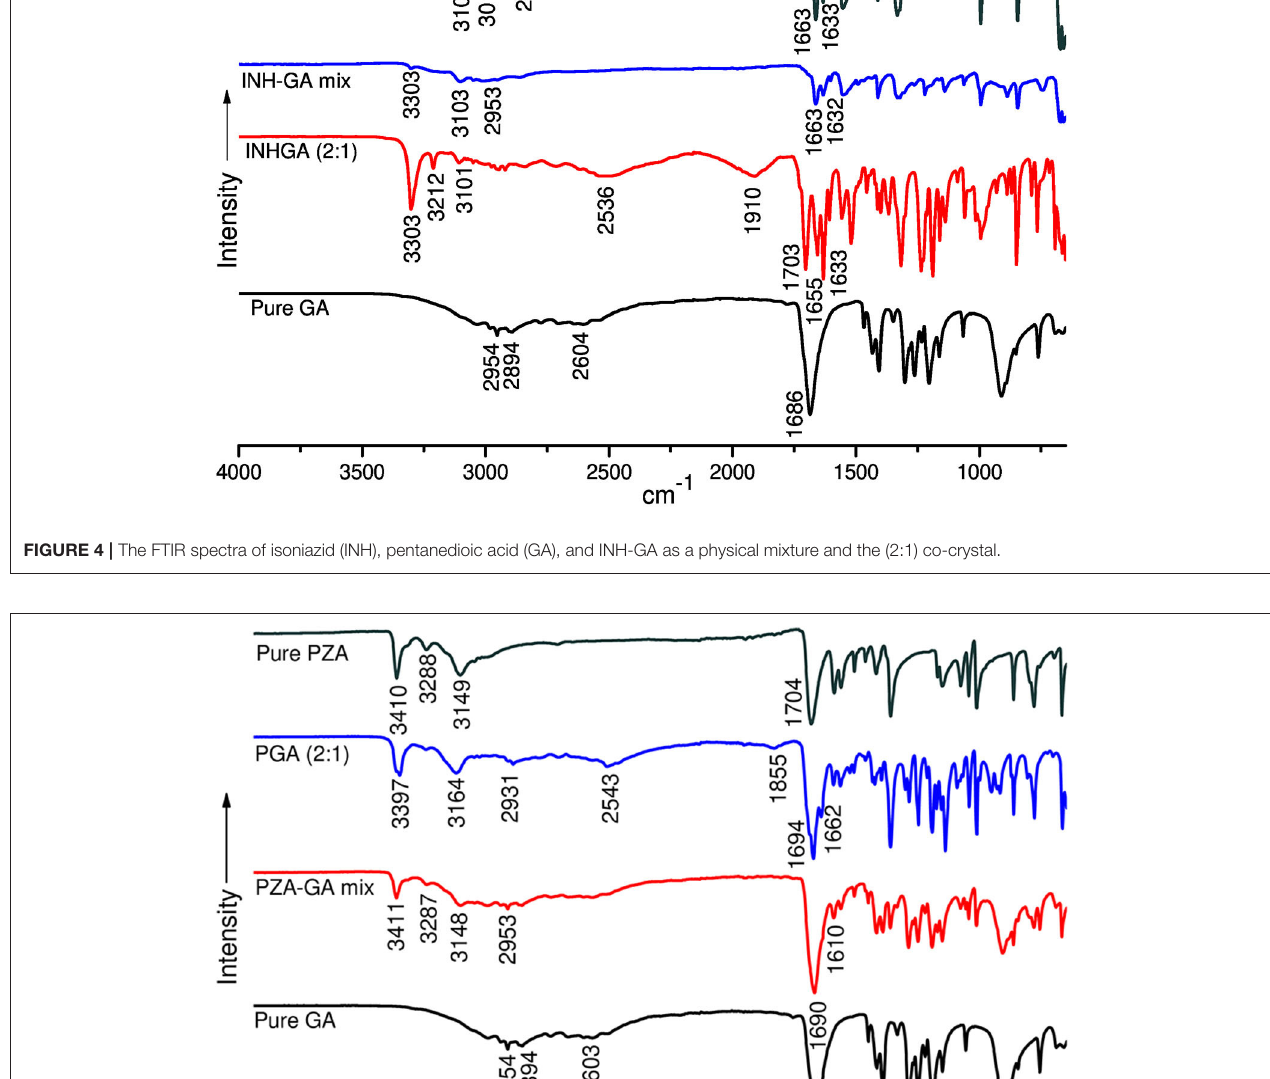
bonding interaction between API and co-formers, alteration in packing arrangements (e.g., polymorphic transition, the formation of eutectic solid mixtures or solid